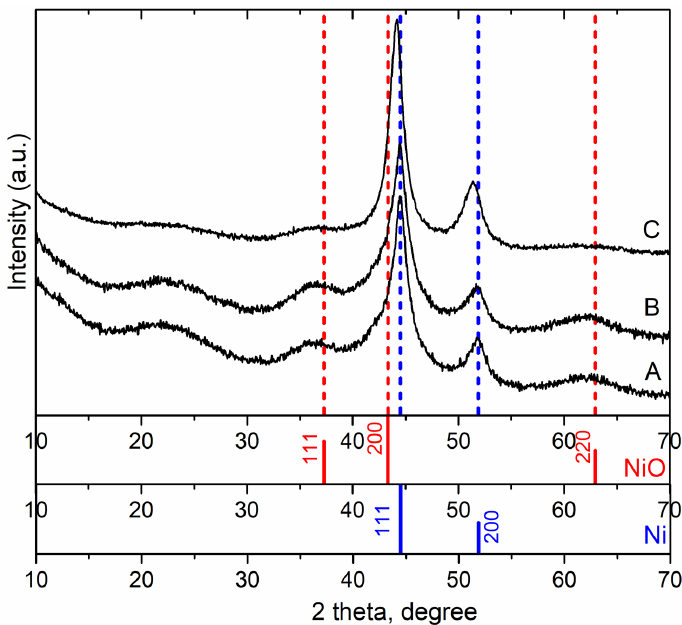
Figure 2. XRD data obtained for the catalysts reduced in H 2 . (A) Ni(36)–SiO 2 , (B) Ni(41)Cu(4)–SiO 2 , (C) Ni(36)Cu(14)–SiO 2 .